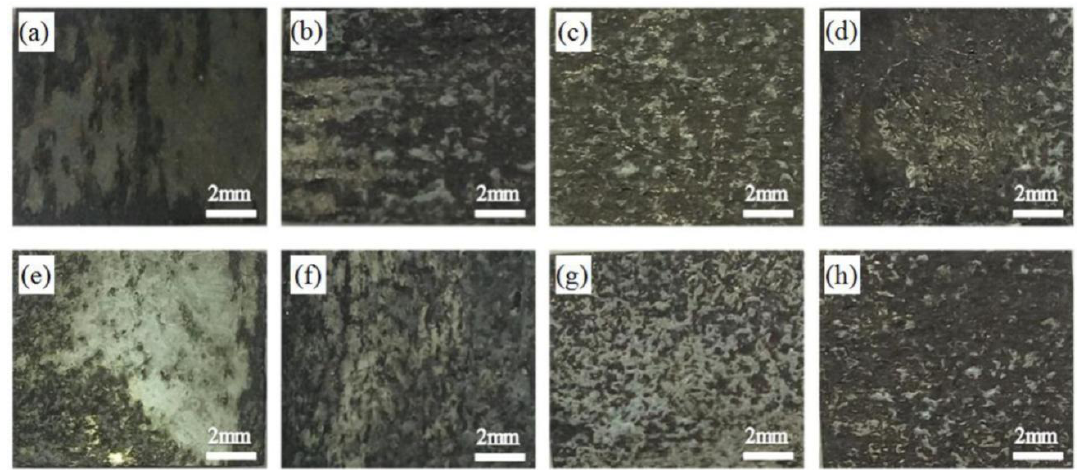
Figure 9. Morphologies of exfoliation corrosion of the alloys with different Cu contents: ( a , e ) 0.98 wt.%Cu; ( b , f ) 1.45 wt.%Cu; ( c , g ) 1.69 wt.%Cu; ( d , h ) 2.02 wt.%Cu; L-T: ( a – d ); S-T: ( e – h ).